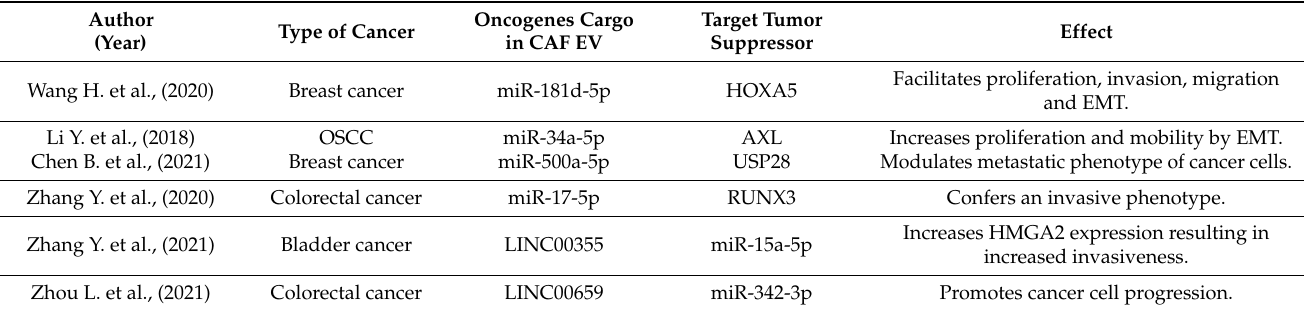
Table 1. Oncogenic cargo from extracellular vesicles of cancer-associated fibroblasts and their effect on cancer cells.